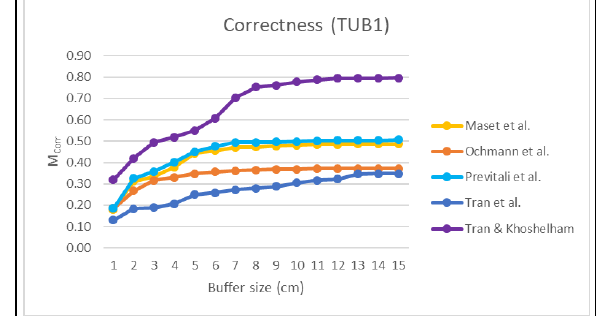
Figure 4. Correctness of submitted models for TUB1 dataset.